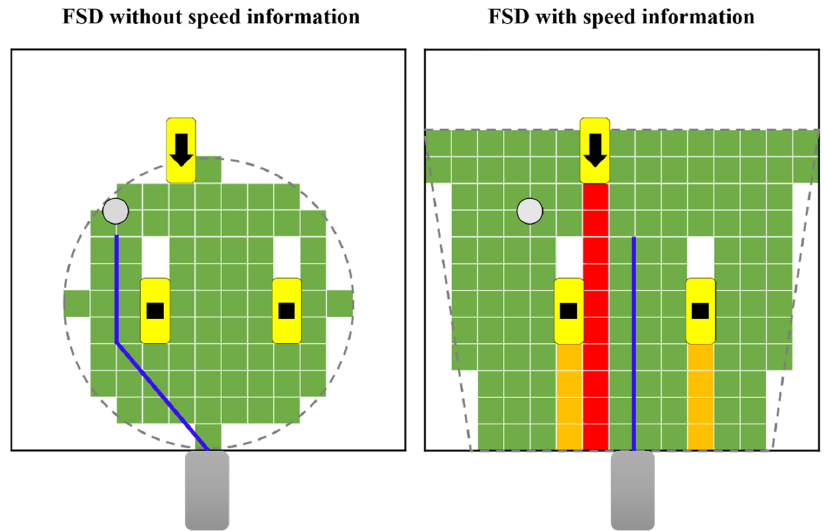
Figure 8. Pictorial result of path generation based on FSD of two methods in case Figure 9a.